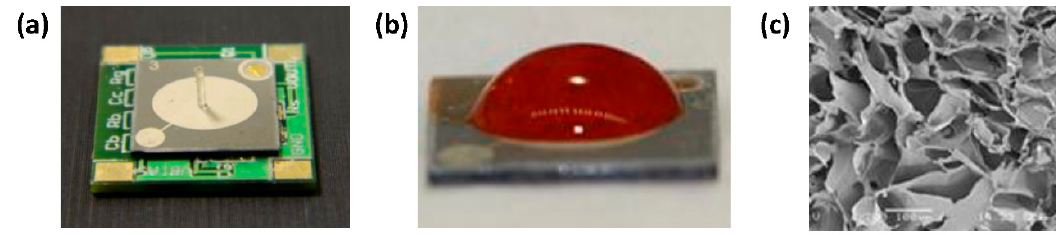
Figure 2. Canal neuromast inspired oscillatory flow sensor ( a ) photograph of PZT membrane with hair-like copper structure and ( b ) HA-MA hydrogel of Young’s modulus 10 kPa. (hydrogel is coloured with rhodamine dye) ( c ) SEM image of the cross-section of HA-MA hydrogel cupula.